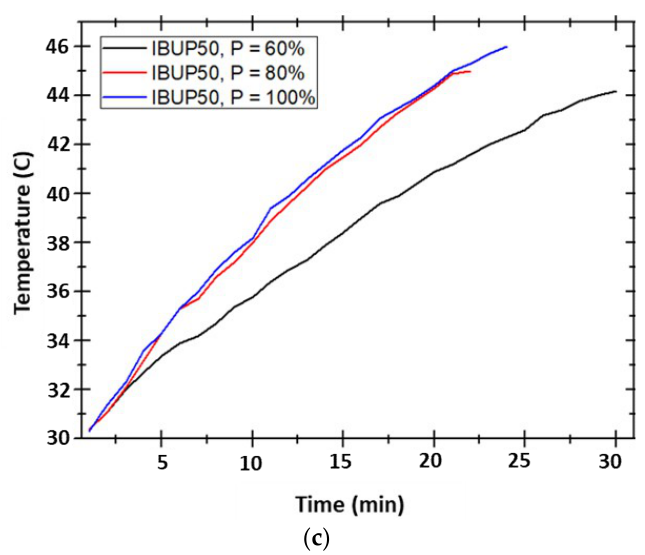
Figure 6. Temperature evolution of PLGA-Fe 3 O 4 -IBUP biopolymeric spheres in the presence of different magnetic fields. ( a ) IBUP10; ( b ) IBUP20; ( c ) IBUP50.